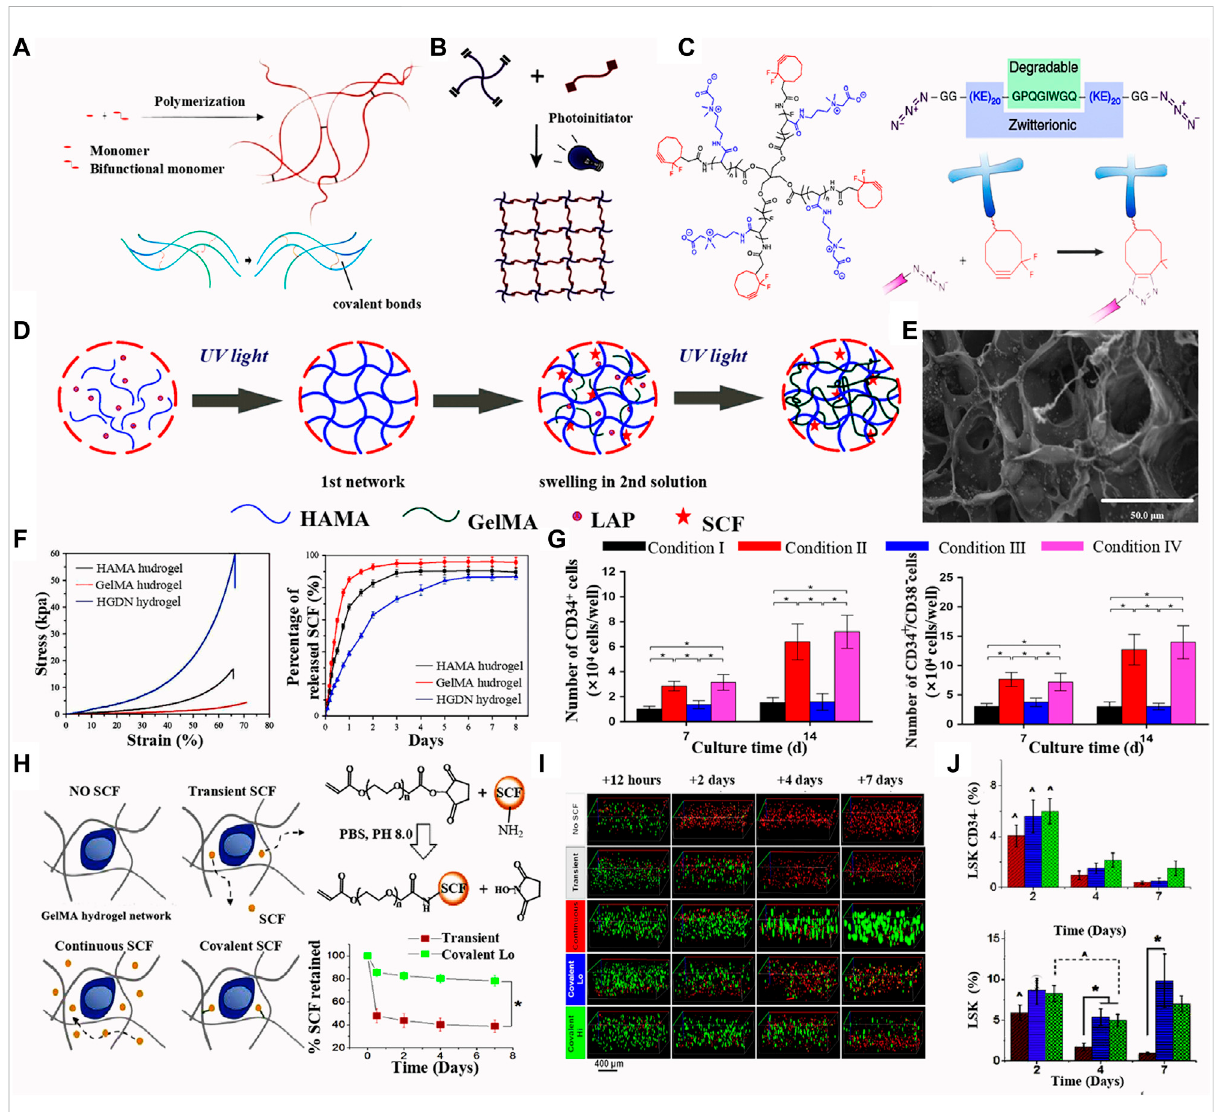
FIGURE 2 (A) Scheme of chemical crosslinking of hydrogel. Upper: (Yin and Cao, 2021) Copyright © 2021. Reproduced with permission from Elsevier. Lower: (Zhang and Khademhosseini, 2017) Copyright © 2017. Reproduced with permission from The American Association for the Advancement of Science. (B) Scheme of photo crosslinking. (Nezhad-Mokhtari et al., 2019 ) Copyright © 2019. Reproduced with permission from Elsevier. (C) Schemes of poly (carboxybetaine acrylamide) with a star-shape; polypeptide crosslinkers with KE sequences as the metalloproteinase